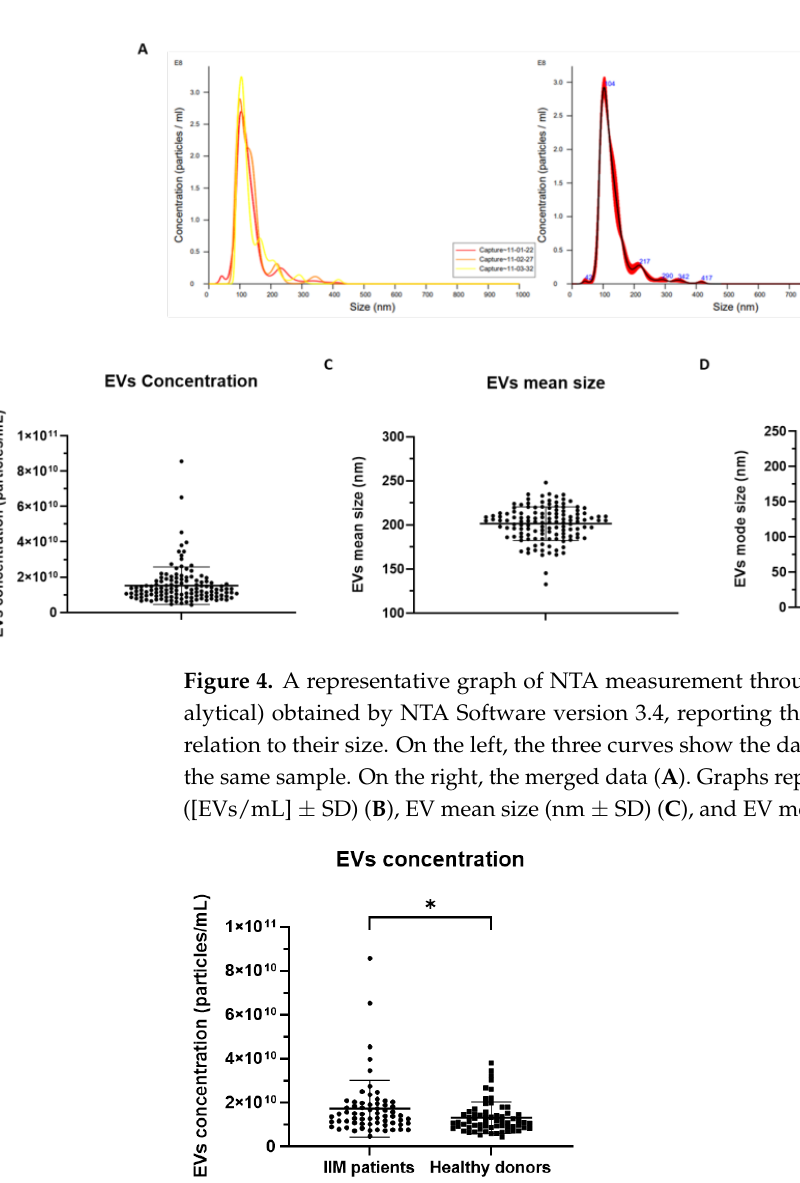
Figure 5. Graphs representing the EV mean concentration ([EVs/mL] ± SD) in IIM patients (n = 65) and HDs (n = 65); * p < 0.05. and HDs (n = 65); * p <